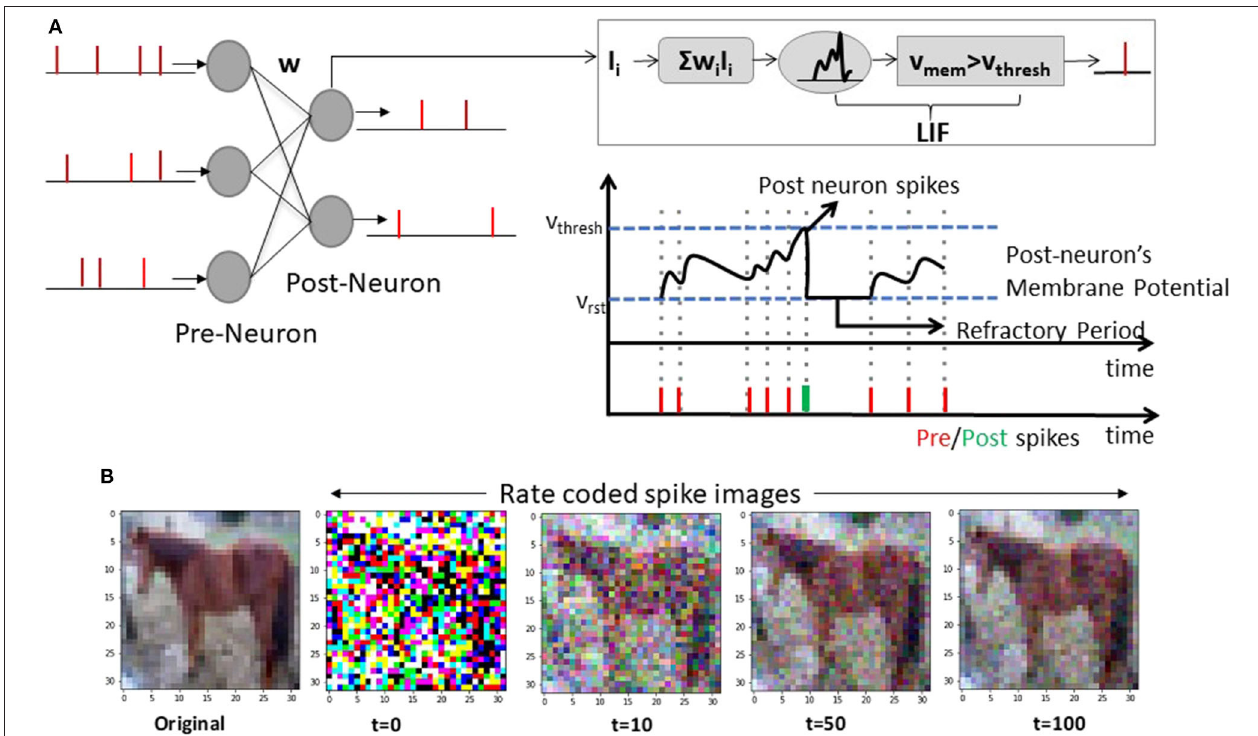
FIGURE 2 | (A) A feedforward fully-connected SNN architecture with Leaky-Integrate-and-Fire (LIF) spiking dynamics is shown. The notations correspond to Equation (1). (B) A sample CIFAR10 RGB pixel image (denoted as original) and corresponding rate-coded spike images at different time instants are shown. The spike image plotted at t = n is a summation of all spike maps from t = 0 to t = n .